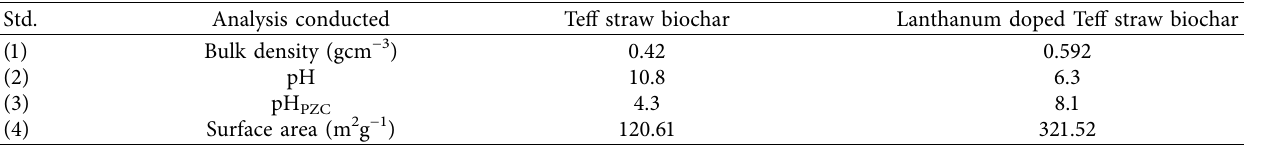
Table 3: Different biochar physiochemical